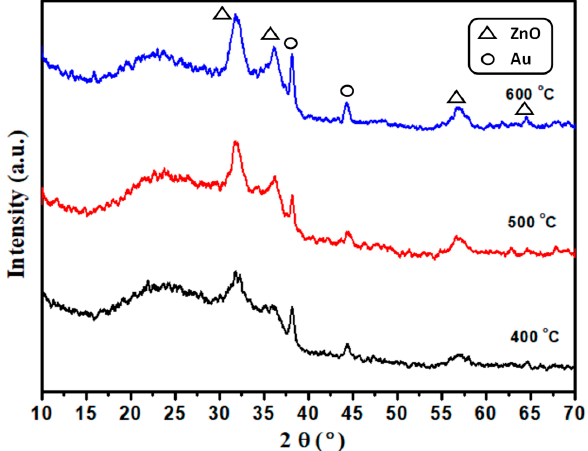
Figure 4. XRD analysis of Au doped ZnO samples.